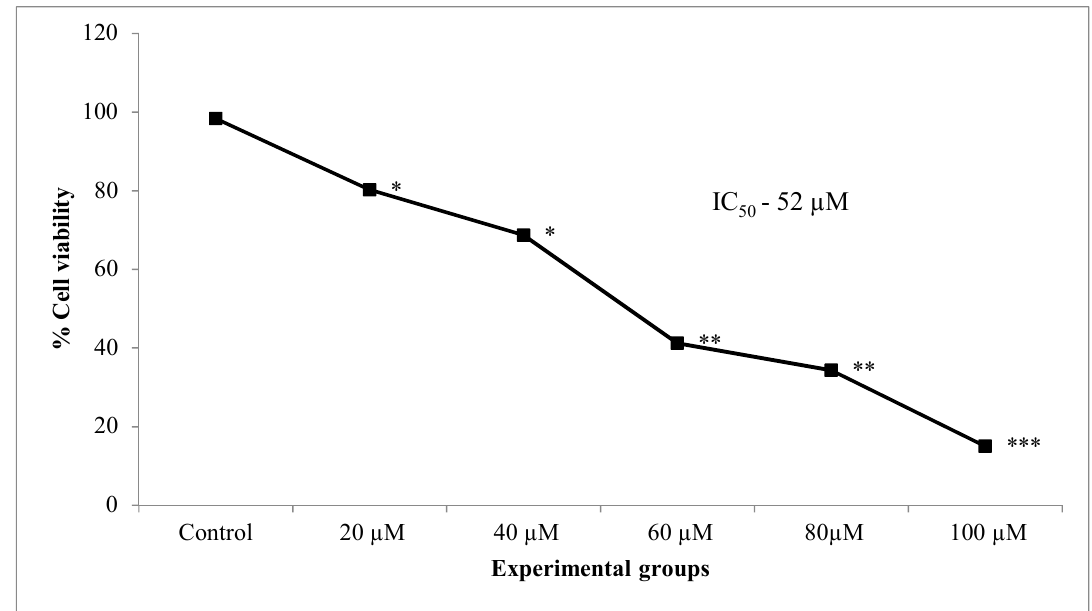
Figure 3. Effect of different doses of CA (20–100 µM) on the percentage cell viability of A549 lung cancer cells. Values presented as mean ± SE from independent duplicate experiments; n = 4. * p < 0.05, ** p < 0.01 and *** p < 0.001.